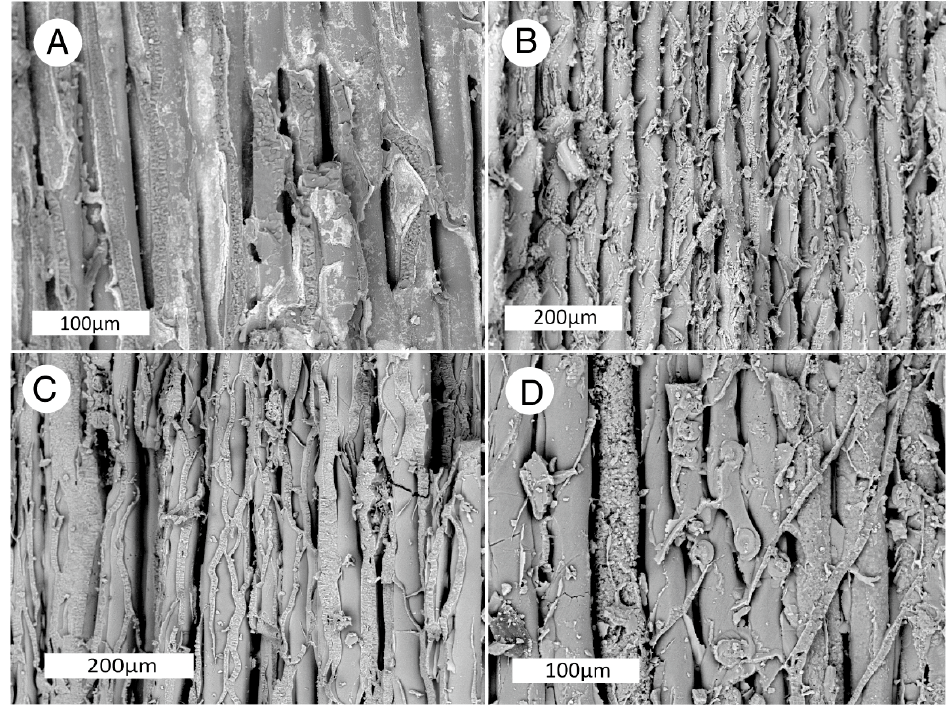
Figure 7. Scanning electron microscope images of Salitre petrified wood, showingunmineralized paces between cells. ( A ) Specimen S1A. ( B ) Specimen S1-C. ( C ) Specimen S2-A. ( D ) Specimen S2-B. Geosciences 2020 , 10 , 49